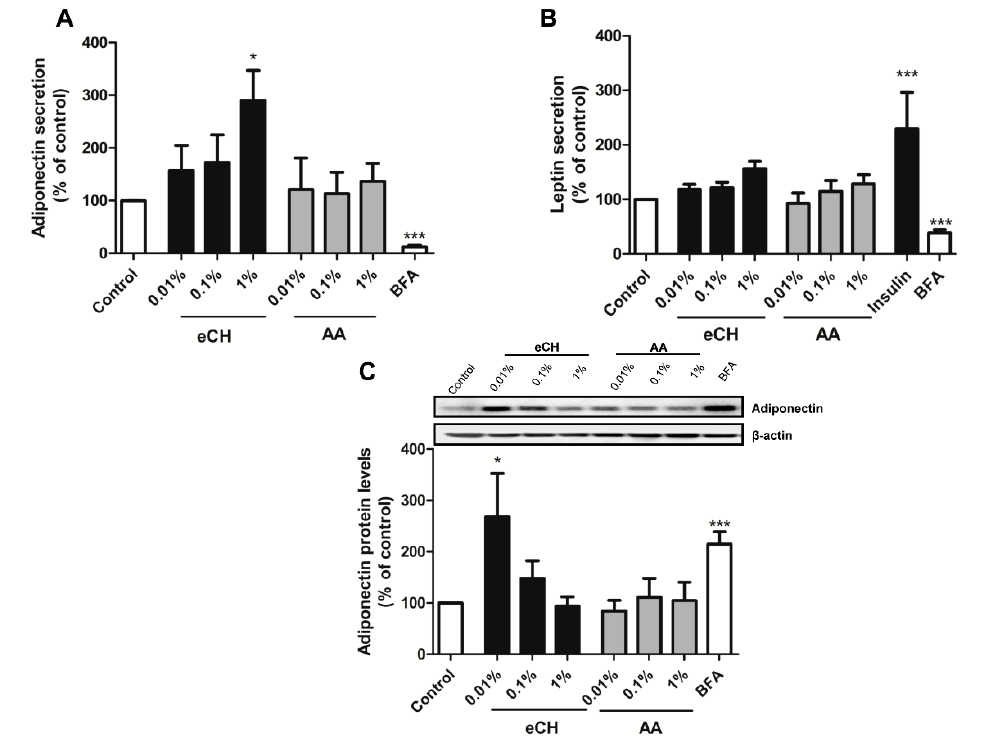
Figure 3. The eCH fraction upregulates adiponectin secretion without increasing intracellular levels. Effect of 24 h challenge with the eCH or AA fractions (at 0.01%, 0.1% and 1%) on adiponectin ( A ) or leptin secretion ( B ). Results were expressed as % of adiponectin/leptin levels triggered by the vehicle. Data are shown as the mean ± SEM of 3–9 independent experiments. Brefeldin A (1 μ g/mL) was used as an inhibitor of protein secretion, while insulin (50 mM) was employed as a positive control for leptin secretion. ( C ) Effect of 24h challenge with the eCH or AA fractions (at 0.01%, 0.1% and 1%) on adiponectin intracellular protein levels. Results were expressed as % of adiponectin basal levels. Data are shown as the mean ± SEM of 3–4 independent experiments. * p < 0.05, *** p < 0.001 vs. % of untreated control.3.3. EPA and DHA Upregulate Adiponectin